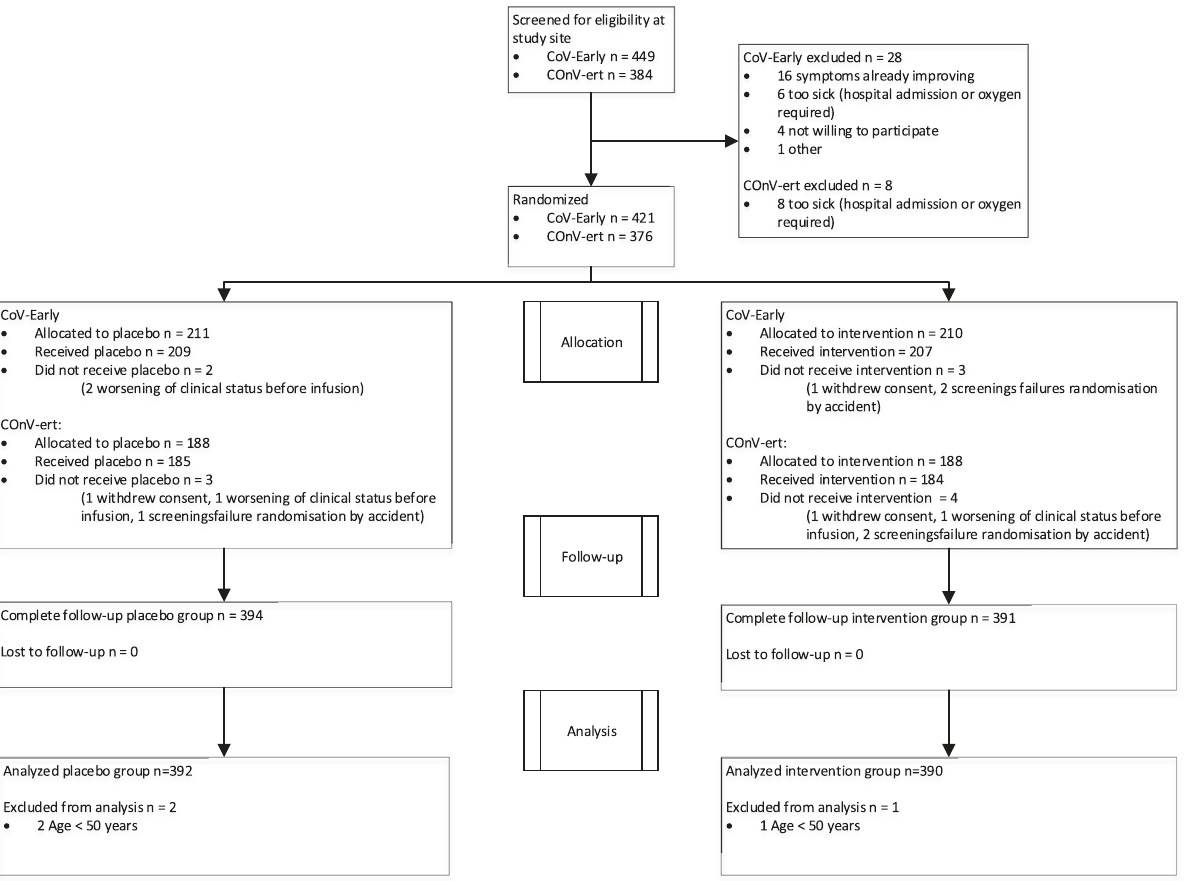
Fig. 1 CONSORT fl ow diagram. Figure shows the CONSORT fl ow diagram of the COMPILEhome patients. 833 patients were screened at a study site and 782 were included for analysis.